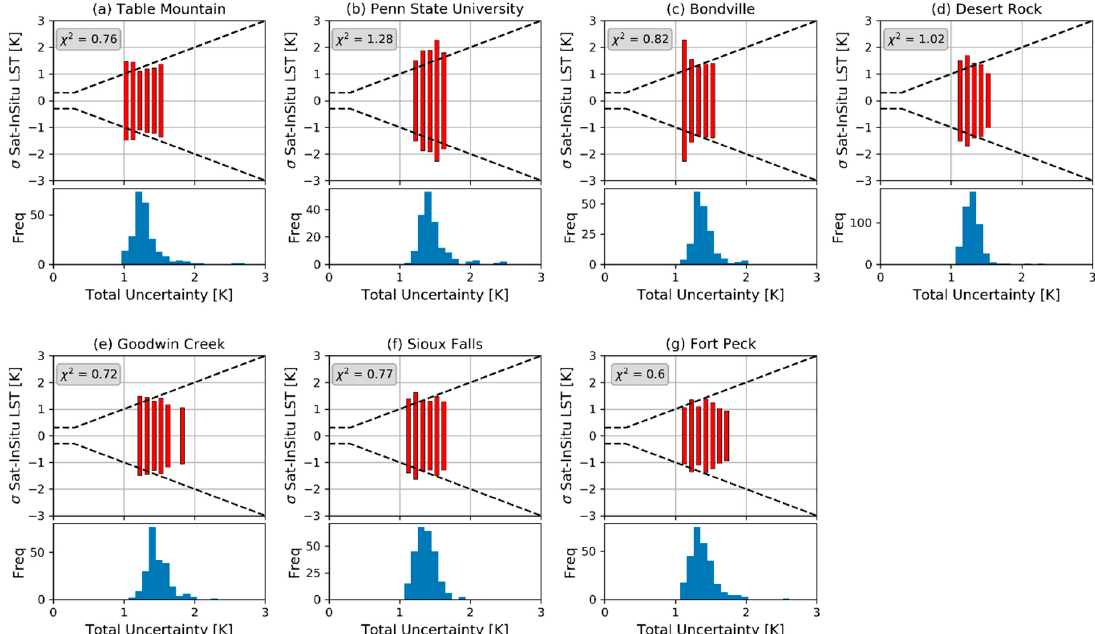
Figure 5. Validation of the satellite uncertainty estimates over seven SURFRAD validation sites: ( a ) Table Mountain, ( b ) Penn State University, ( c ) Bondville, ( d ) Desert Rock, ( e ) Goodwin Creek, ( f ) Sioux Falls, ( g ) Fort Peck. The standard deviation of satellite LST minus ground-based LST is plotted against bands of the total uncertainty budget for the matchup. The cone shape is distorted near zero since the in situ instruments have a calibration uncertainty. Chi-squared goodness-of-fit values are given for each site.